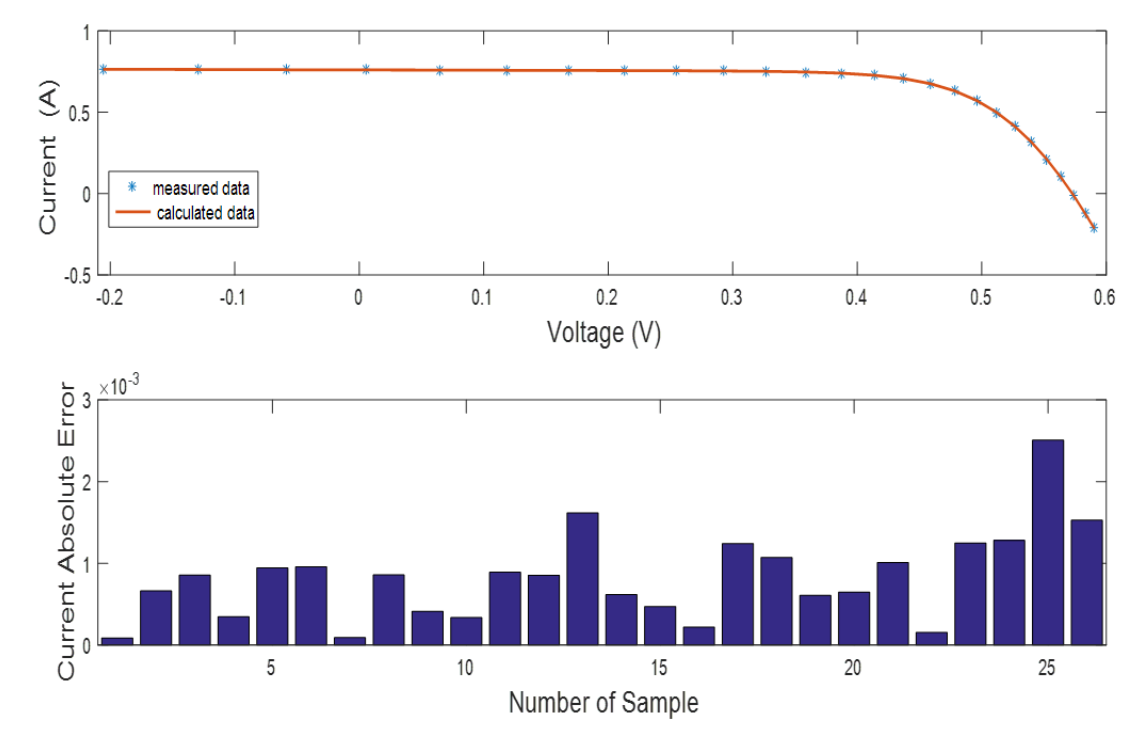
Figure 7. The SDMSC’s I–V curve based on the best solution from the INFO algorithm.